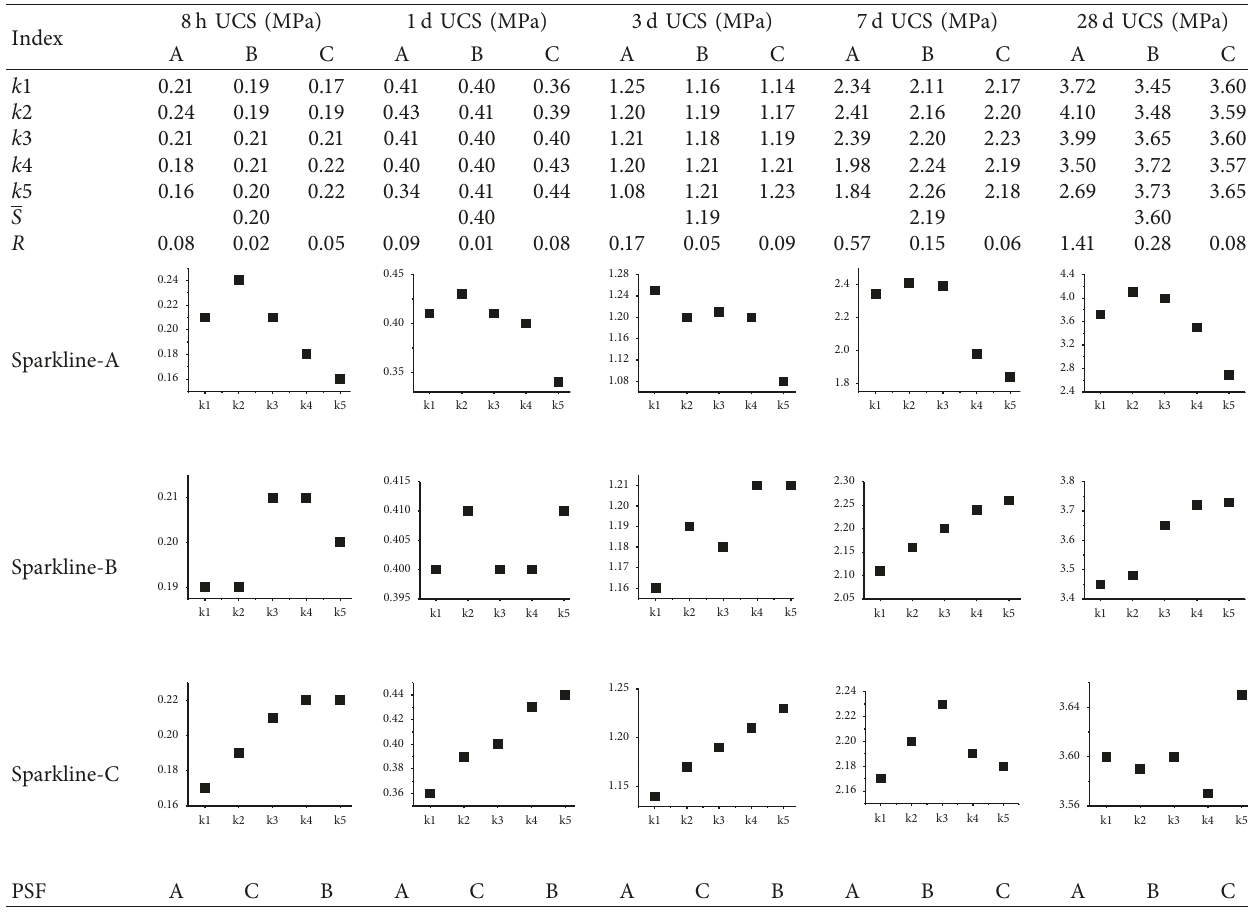
Table 4: Range analysis of compressive strength of the paste filling material